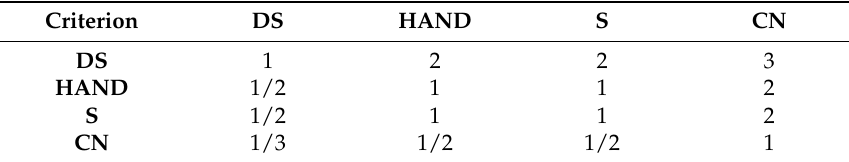
Table A2. Pairwise comparison for flood hazard S2.